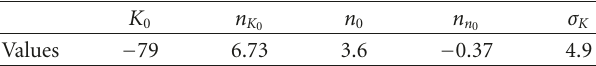
Figure 7: Variation of the K factor at 3 and 5 GHz, versus distance, and deduced from measurements. Its average variation calculated from an empirical mathematical expression is also plotted. Table 2: Parameters to be introduced in (10) for modeling the variation of the K factor.